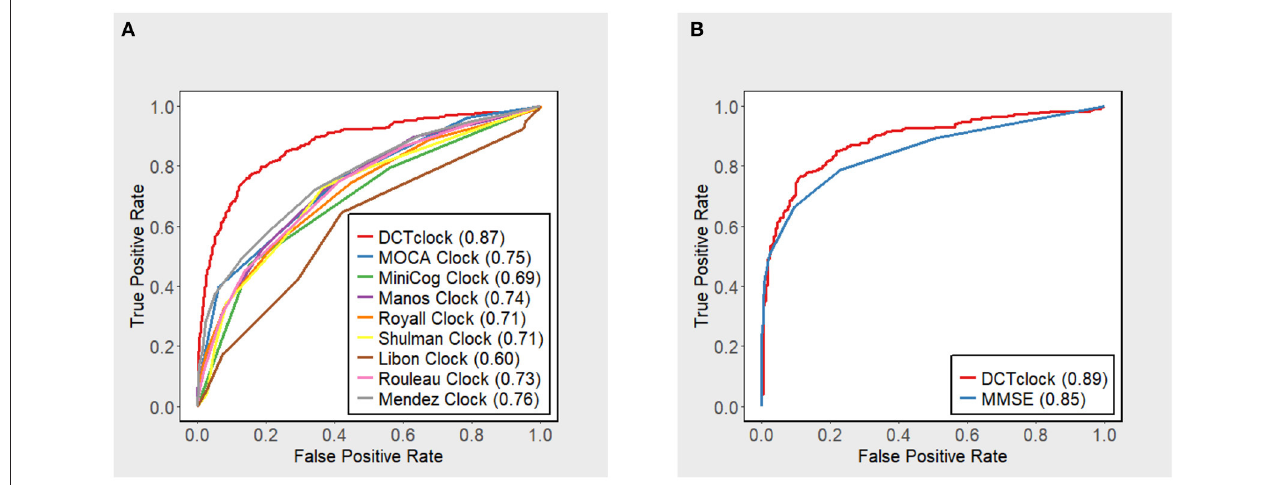
FIGURE 2 | ROC curves with accompanying AUC estimates for DCTclock scores and (A) operationalized clock scoring systems and (B) MMSE.